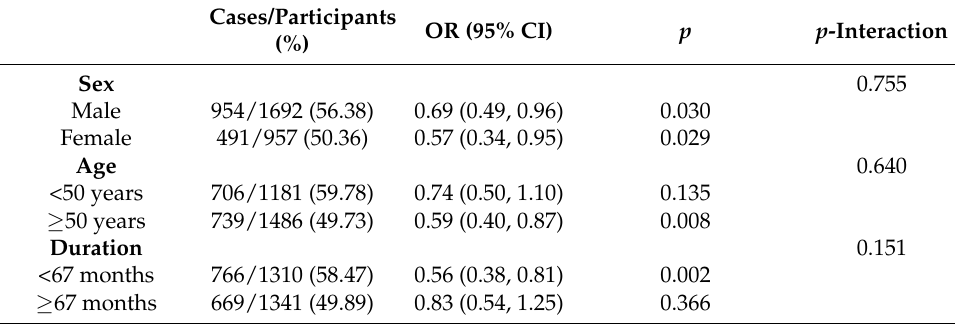
Table 3. Subgroups analyses for the prevalence of nonalcoholic fatty liver disease among 2667 participants with the highest vs. lowest intake of